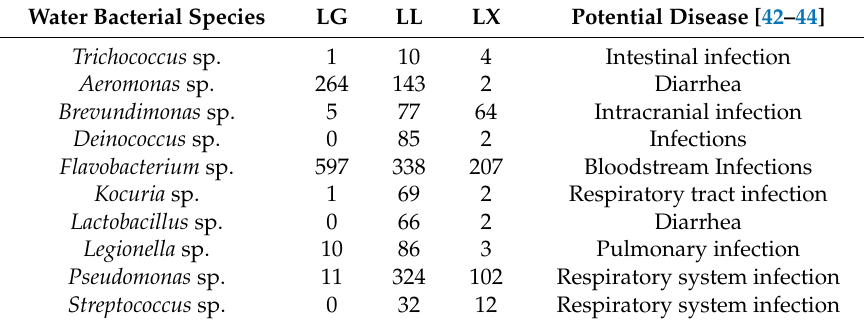
Table 5. Relative abundance of OTUs related to human diseases.